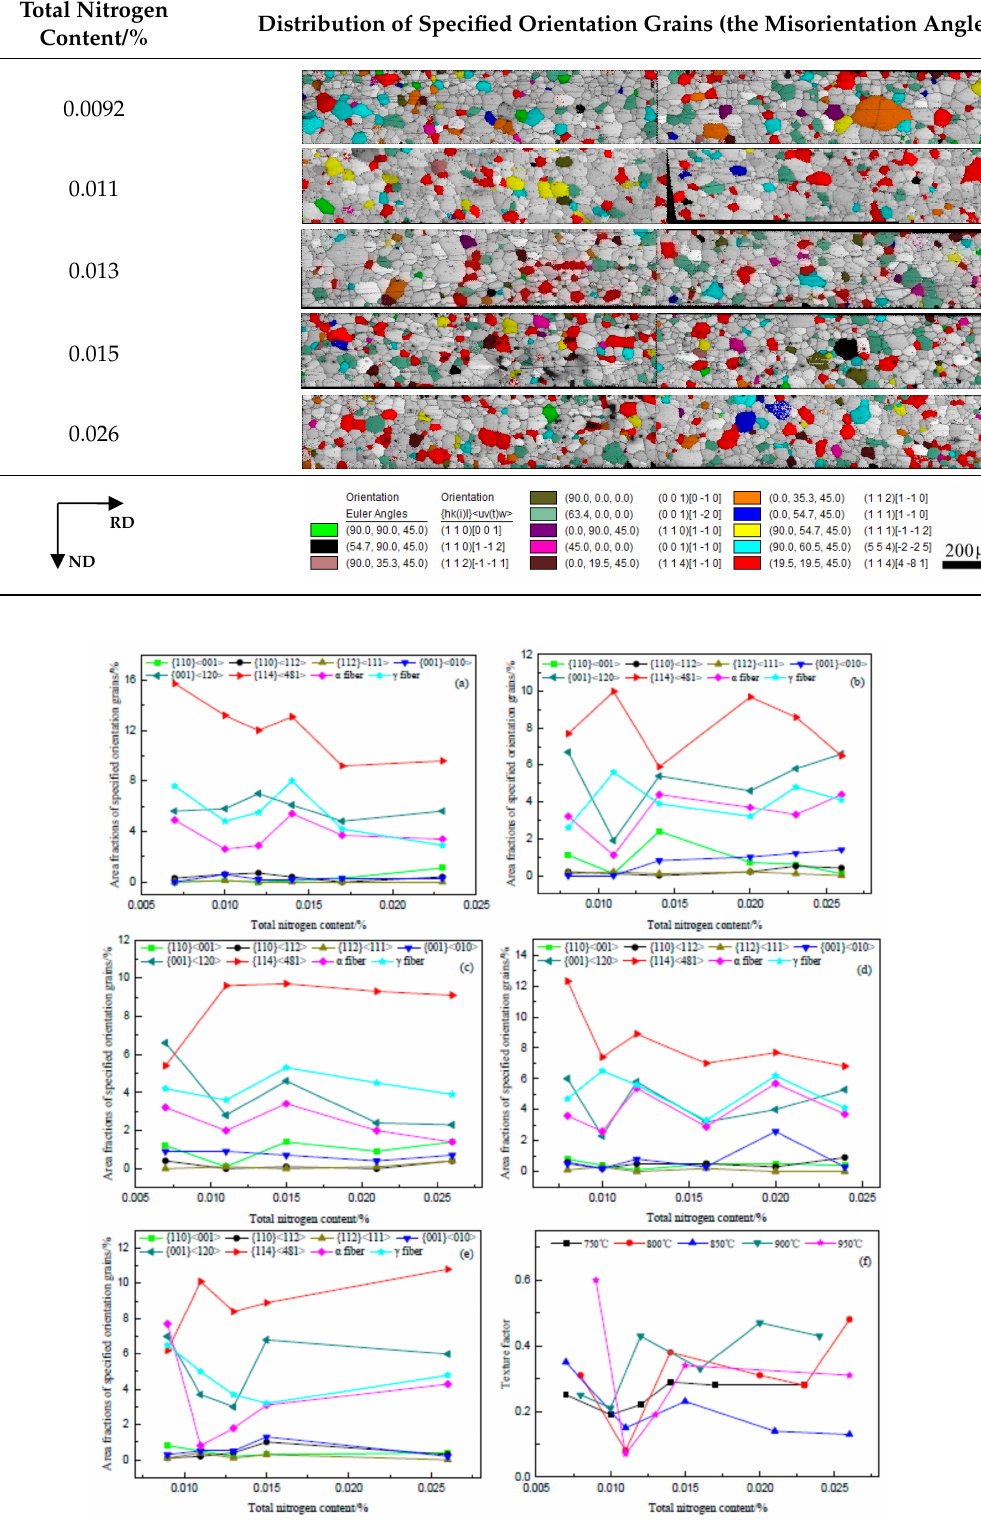
Figure 3. Relation between total nitrogen content and the area fractions of specified orientation grains and texture factor of a decarburized sheet after nitriding annealing at different